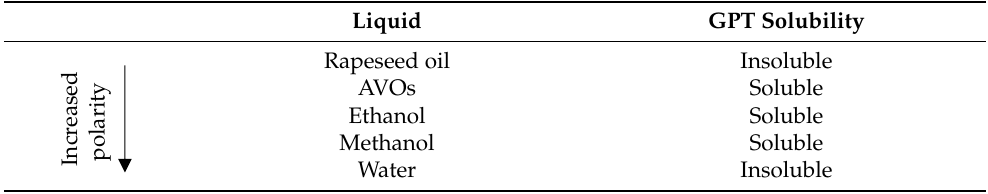
Table 2. Solubility of GPT monomer in different solvents at room temperature.